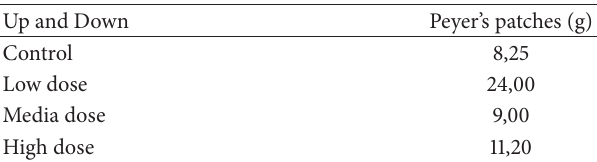
Table 2: Weight of the Peyer’s patches removed after sacrifice in the Up and Down